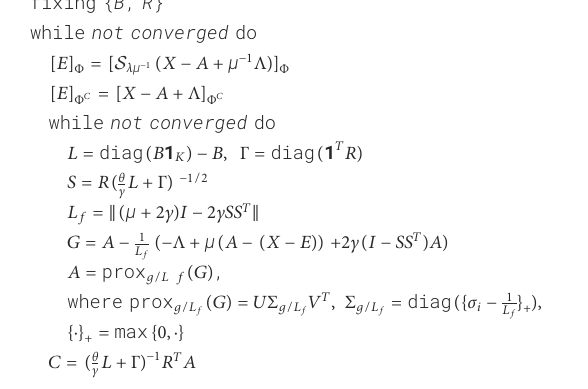
Algorithm 1. The Algorithm of solution for A , E , C with fi xed B , R